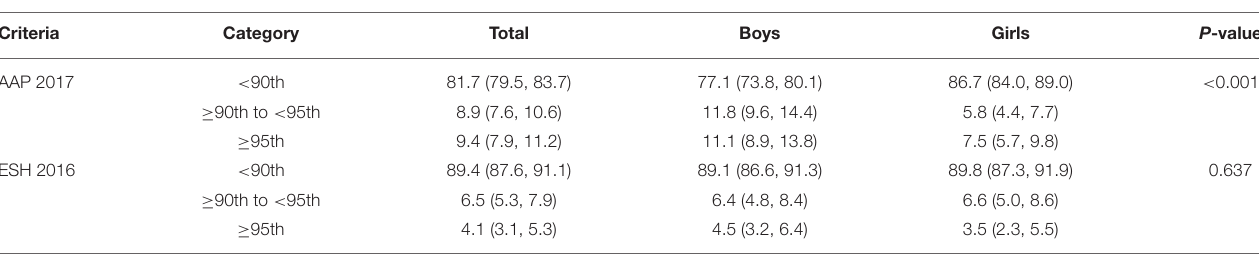
TABLE 2 | Prevalence of hypension by different criteria.